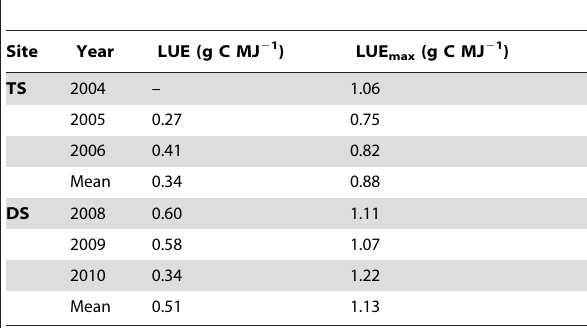
Table 1. Annual average light use efficiency (LUE) and maximum light use efficiency (LUE max ) at each site.